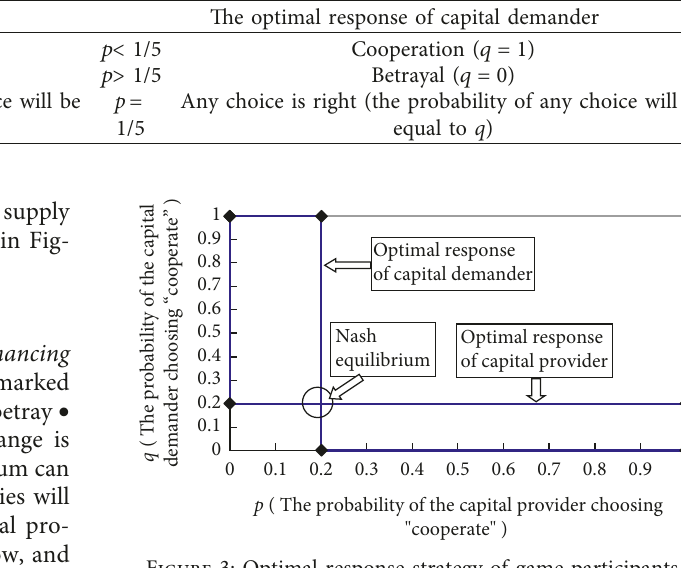
Table 3: Optimal response strategy of game participants.